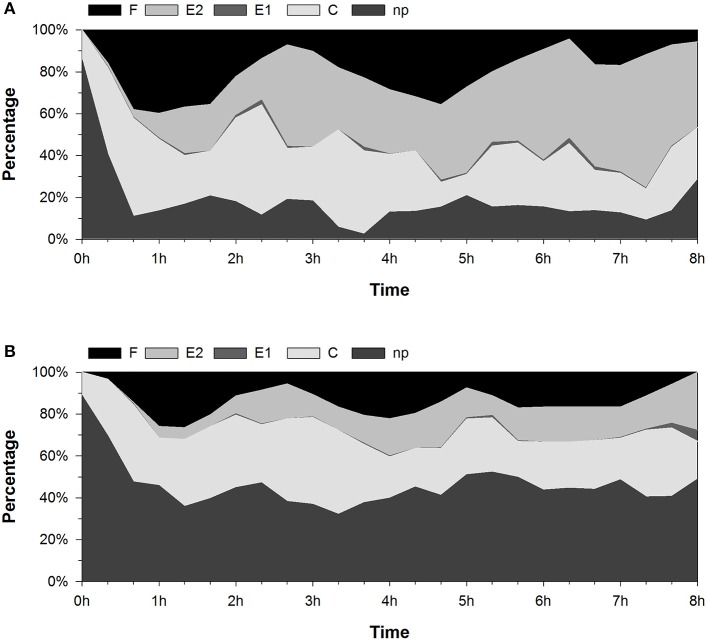
Percent change in the stylet activity of Acyrthosiphon pisum during 8-h EPG recordings. The data show the percentage of the duration of EPG waveforms in every 20-min interval. (A) LTA control group. (B) NPF treatment group.